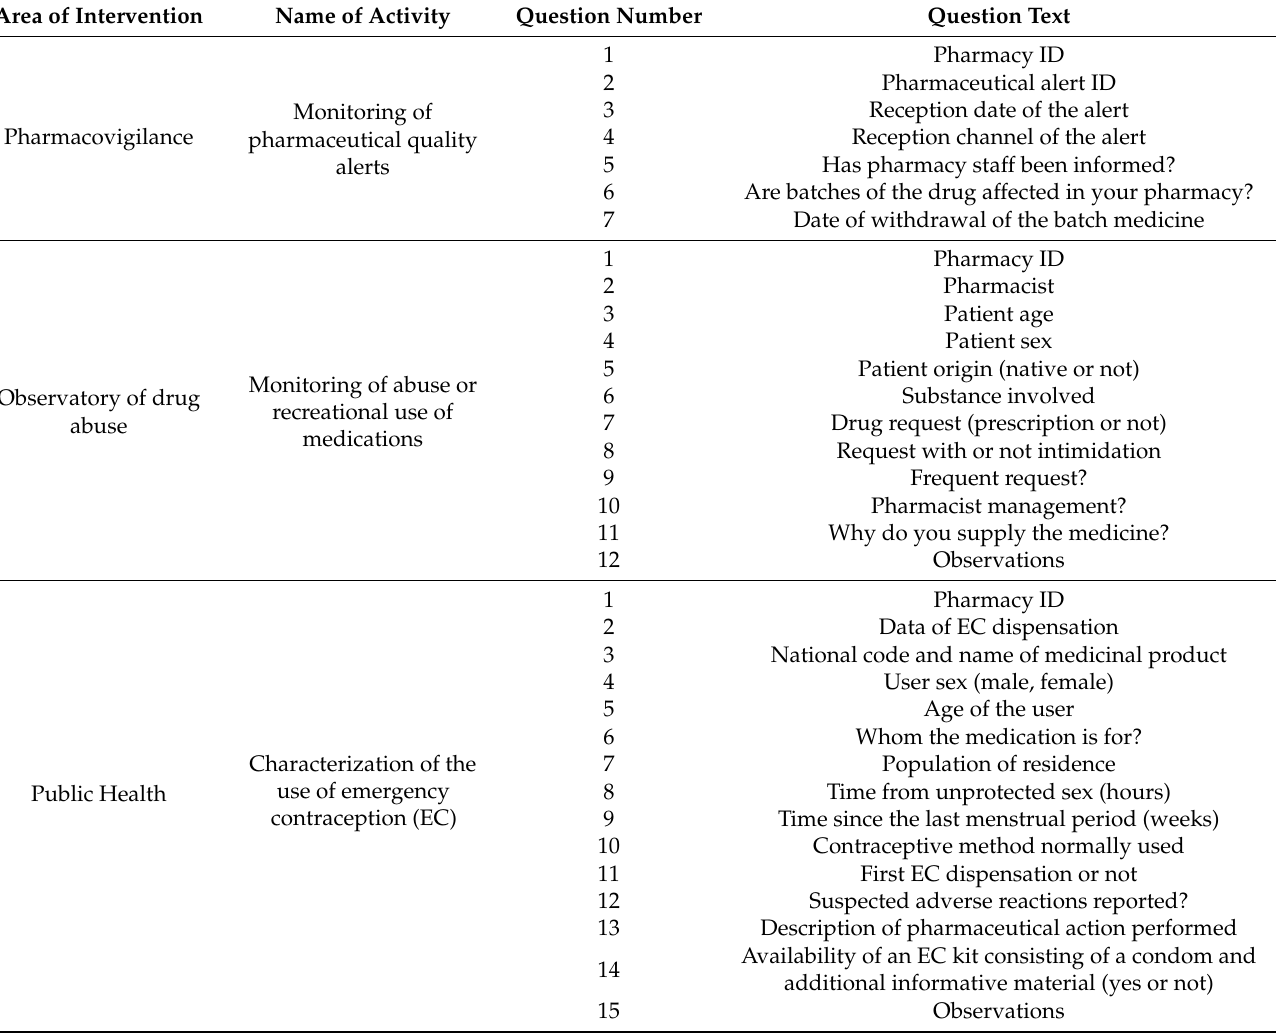
Table 5. Validated questionnaire templates for sentinel pharmacy data